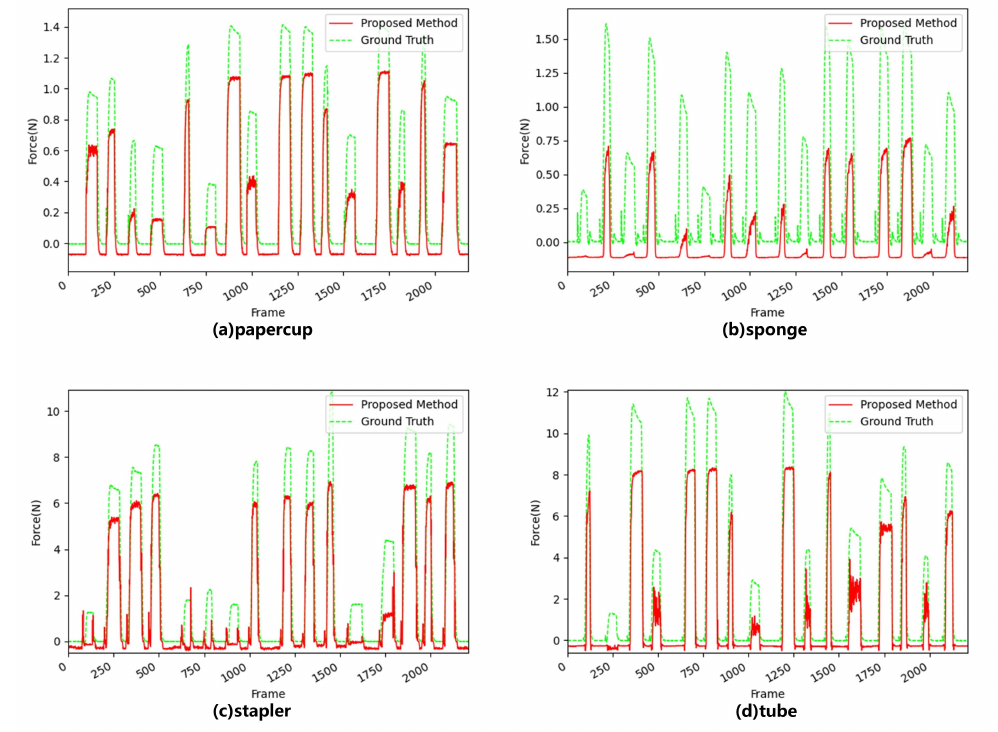
Figure 8. Performance of a single frame as input. Where green is the ground truth and red is the predictive force